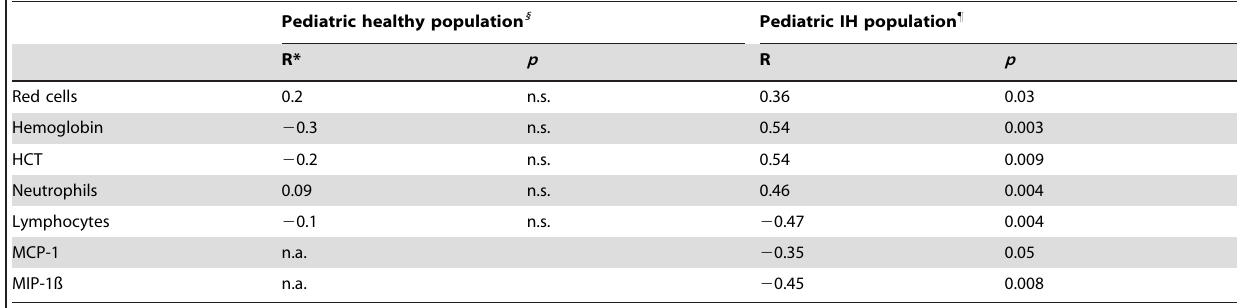
Table 3. Correlation with